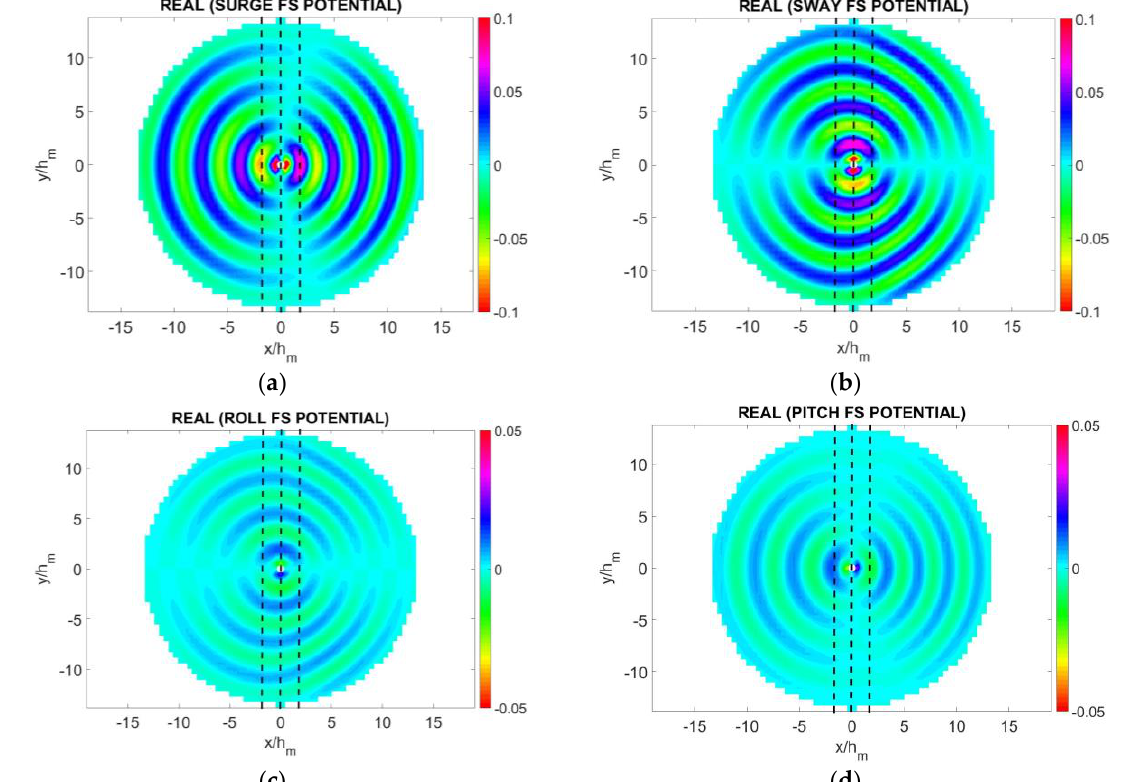
(cid:112) a / g = 0.7 over the variable bottom